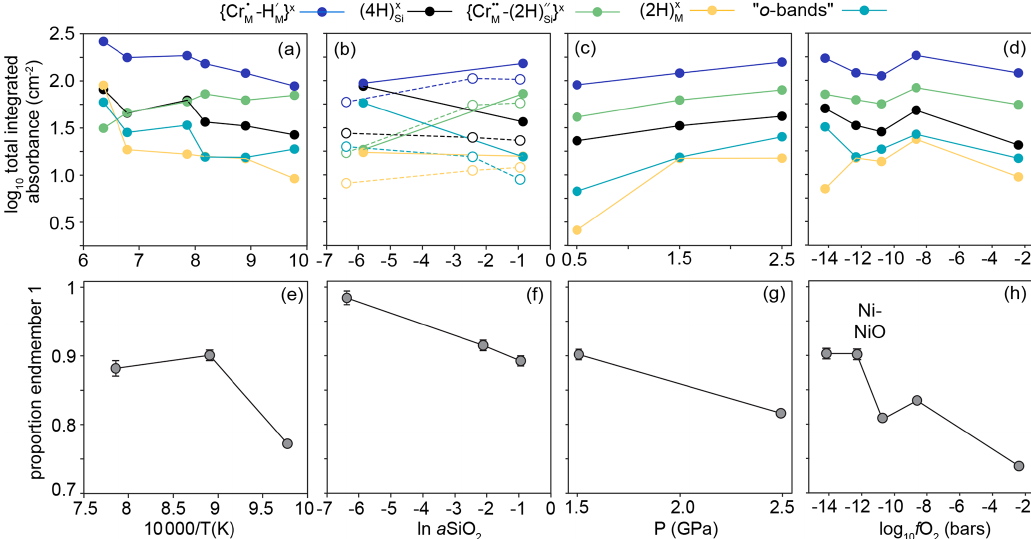
Figure 6. The effect of (a) temperature, (b) a SiO 2 , (c) P and (d) f O 2 on the integrated total absorbance from FTIR spectra recorded at the interface (corrected for orientation and thickness) for the peaks associated with the five defect types expressed at the interface (not including m -bands). Lines between the data points are for a visual guide only. In (b) , the filled circles and solid lines relate to samples from the 950 ◦ C experiments and open circles and dashed lines to samples from 850 ◦ C experiments. (e) , (f) , (g) and (h) are equivalent to (a) , (b) , (c) and (d) , respectively, and show the proportion of end-member 1 from linear combination fitting of XANES spectra. See Fig. 9 for examples of linear combination